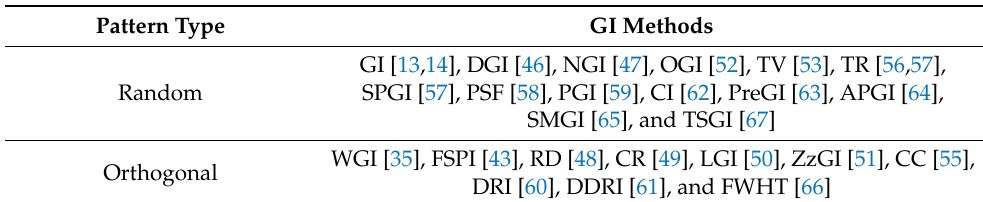
Table 1. Pattern types and methods used for simulations.